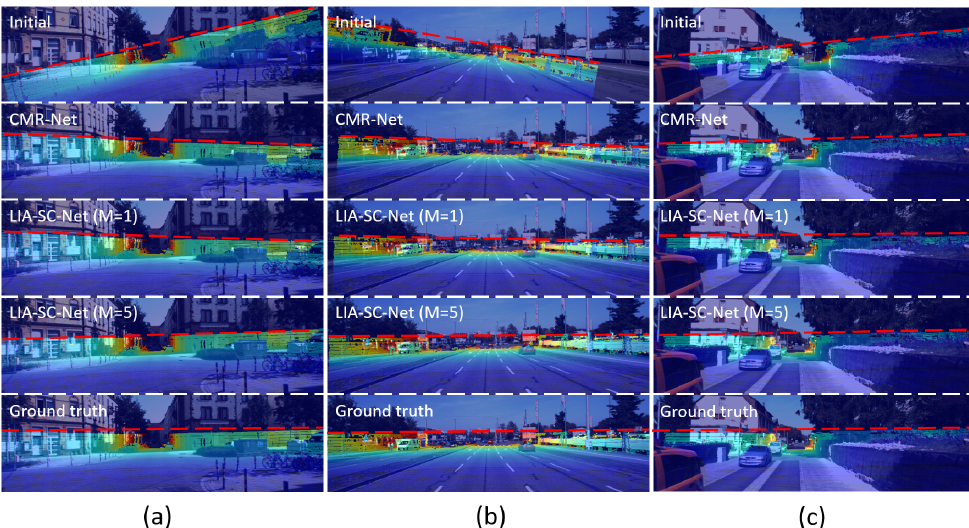
Figure 9. Calibration visualization of different learning based calibration methods in the various scenes ( a – c ). Images mixed with LiDAR depth and RGB image are used for